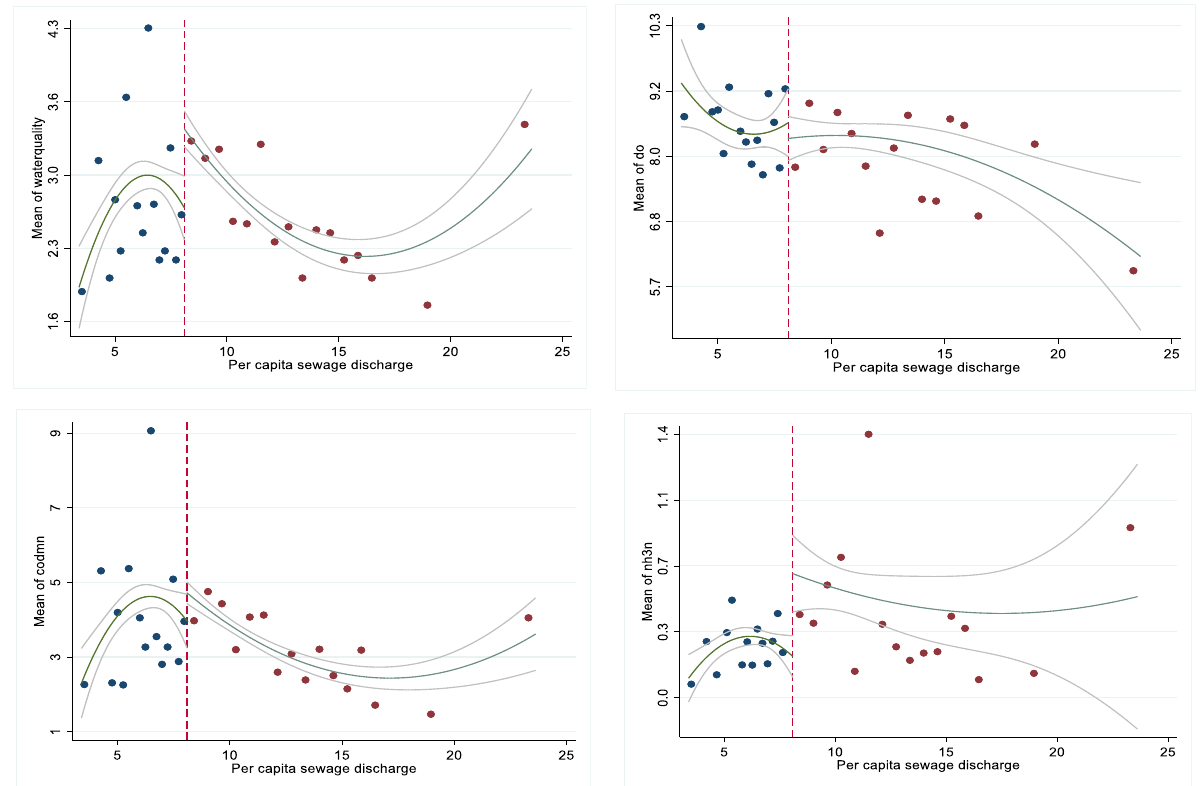
Figure 5. The discontinuities in per capita sewage discharge after the implementation of RCS. Note: The x-coordinate represents per capita sewage discharge, and the y-coordinate represents water quality. Table 5. Empirical results of factors influencing the effectiveness of RCS.